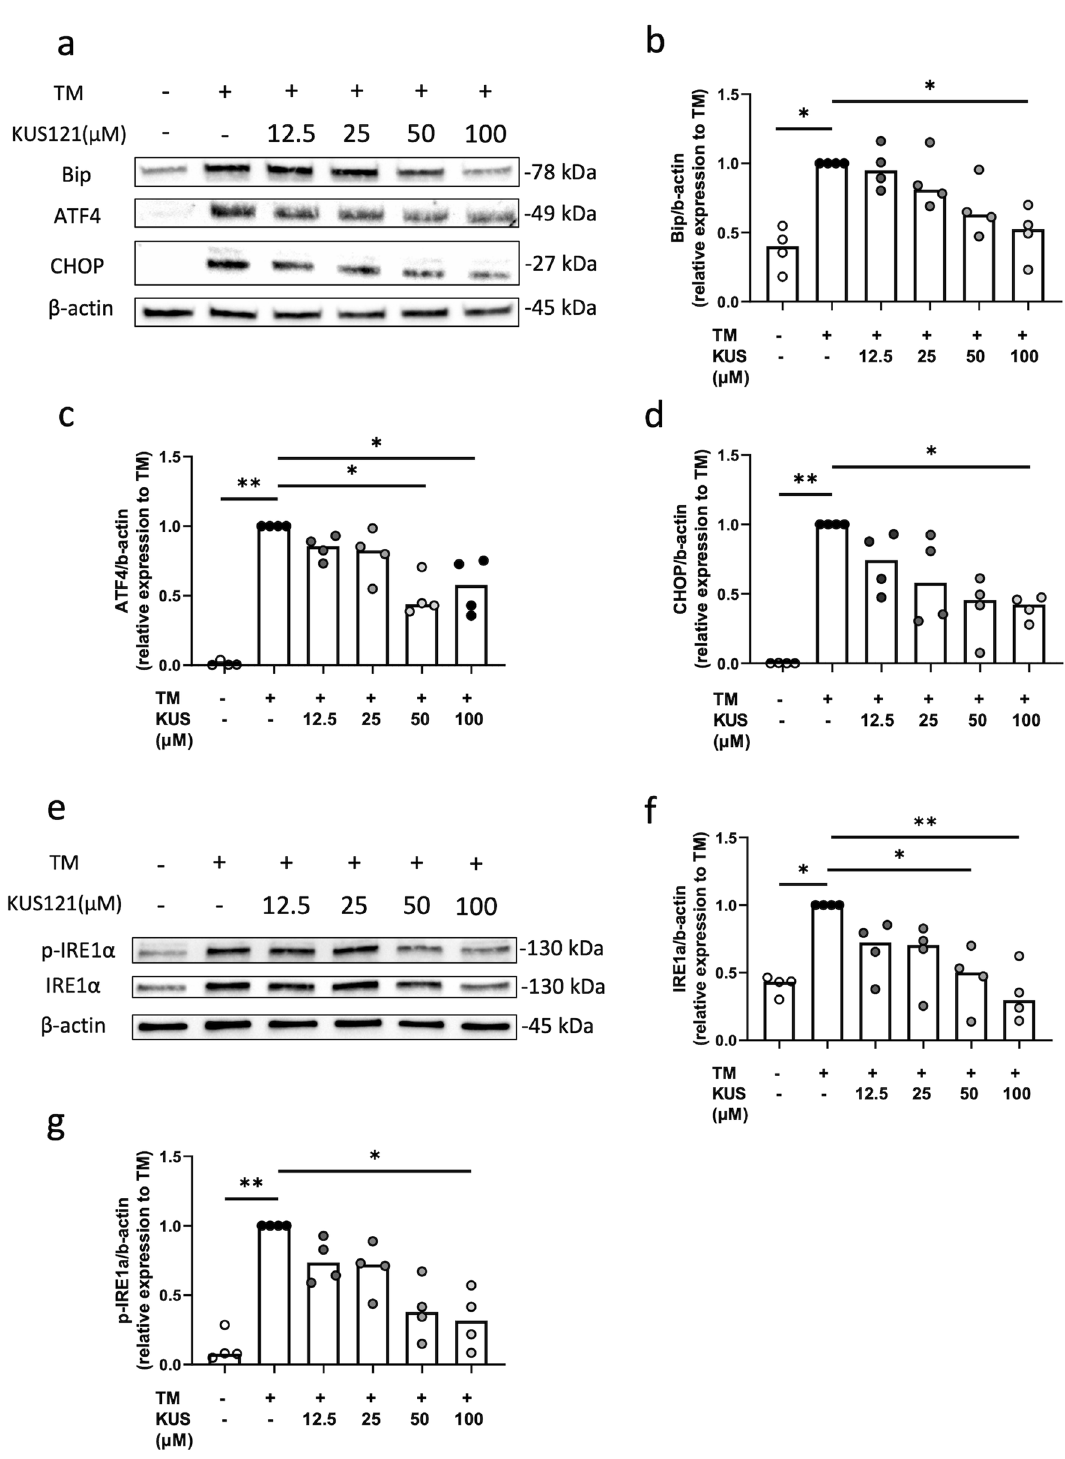
Figure 4. A correct version of the original Figure